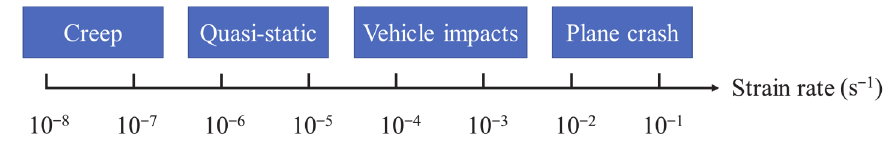
Figure 2. Regimes of strain